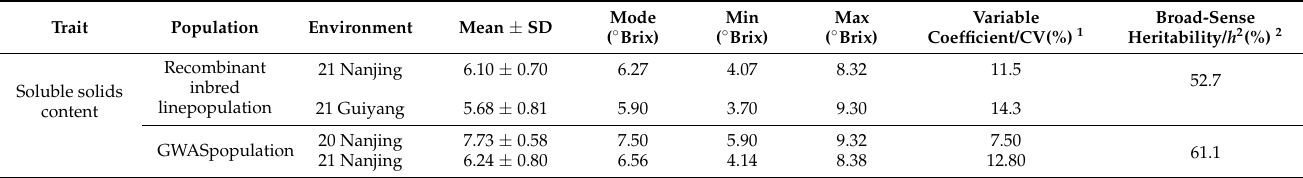
Figure 1. Phenotypic variation in SSC of the B. napus shoots. AH RIL ( a ) and GWAS populations ( b ). The x –axis represents the SSC (Brix), and the y –axis represents frequency. “A” and “H” indicate the average SSC of the female parent “APL01” and the male parent “Holly” in two experiments, respectively. Table 1. Statistical analysis of soluble solids content in B. napus shoots.